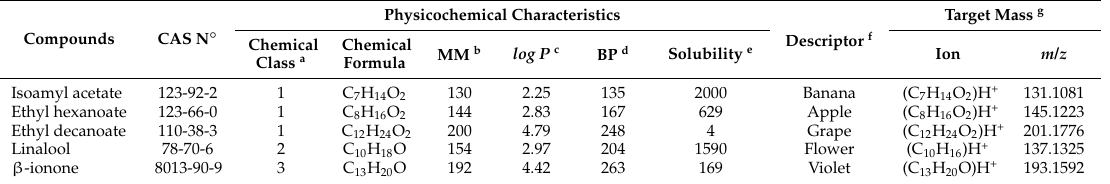
Physicochemical characteristics and proton transfer reaction—time-of-flight—mass spectrometer fragmentation patterns of the aroma compounds added to the wines.